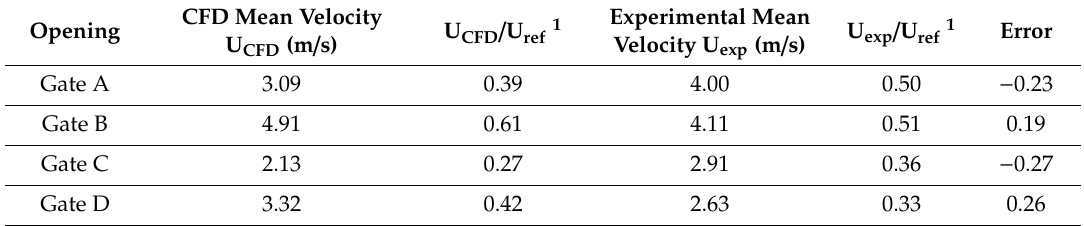
Table 4. CFD wind velocity validation results under the wind direction of 350 ◦ .